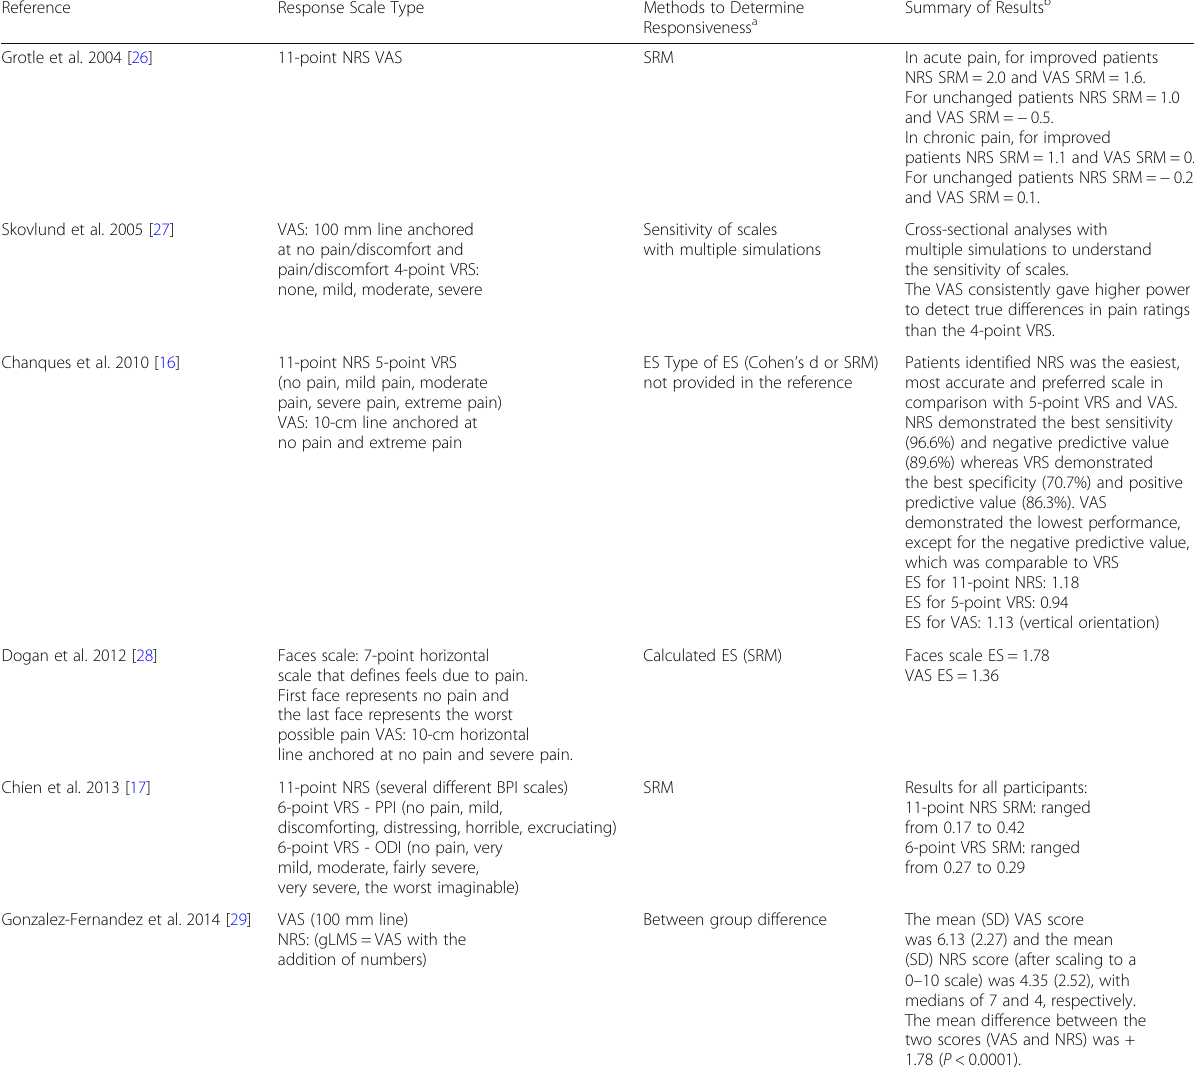
Table 2 Key studies that support response scale selection for PRO instruments based on responsiveness